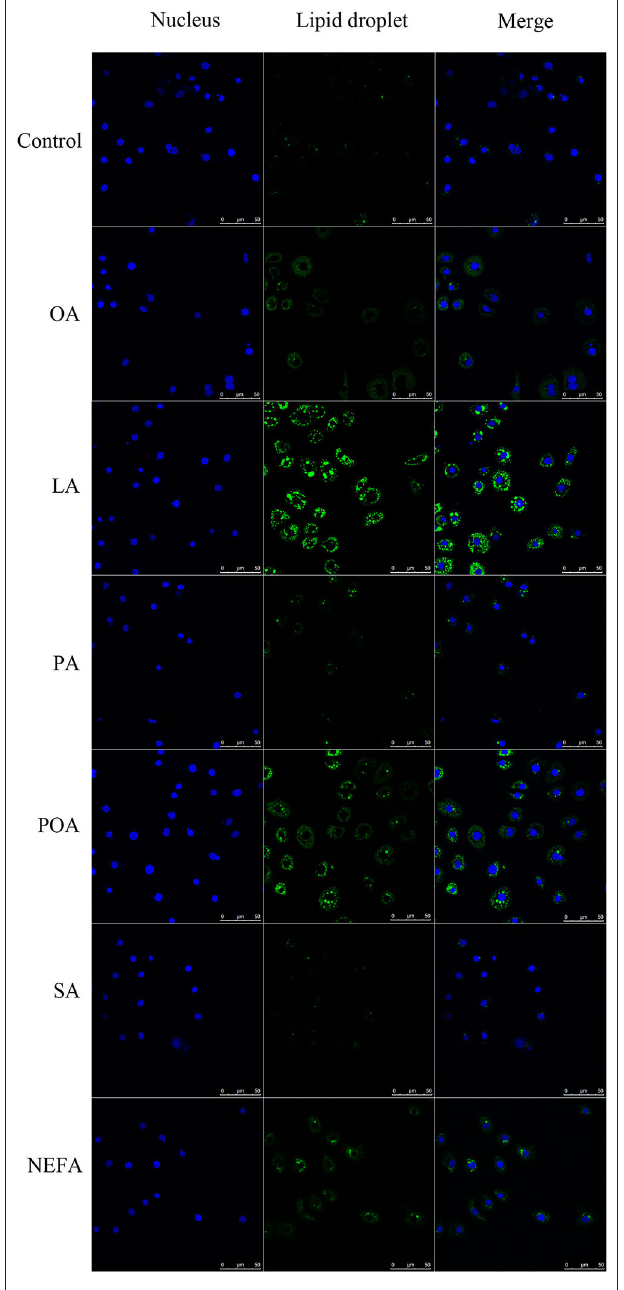
FIGURE 3 | Effects of fatty acids on the formation of lipid droplets. Cells were treated with 1.2mM fatty acids s for 12h, then lipid droplets in cells were stained by BODIPY, and cell nuclei were stained by Hoechst. Blue fluorescence indicates cell nuclei; green fluorescence indicates lipid droplets, the intensity of green fluorescence increases with the number of lipid droplets in the